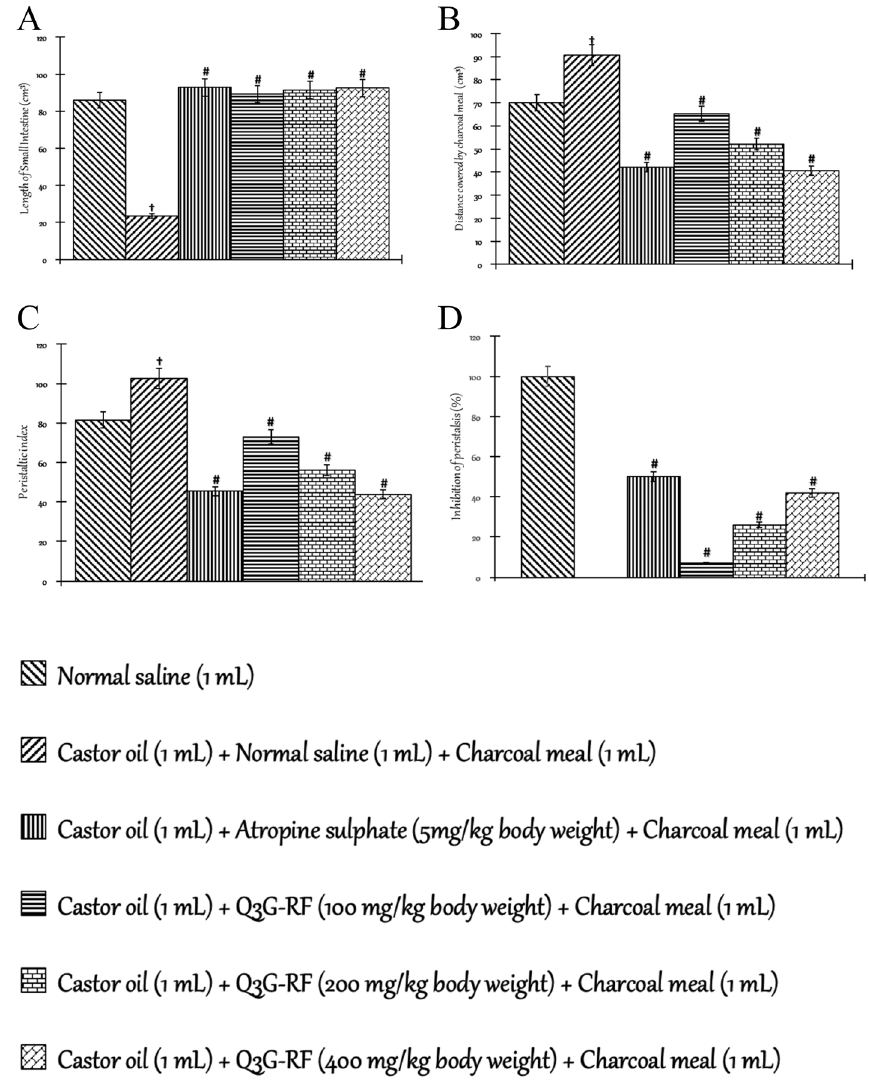
Fig. 8 Effect of Q3G-RF from S. mombin leaves on gastrointestinal motility using charcoal. Length of small intestine ( A ), distance covered by charcoal meal ( B ), peristaltic index ( C ), and inhibition of peristalsis ( D ) of male Wistar rats treated with normal saline, castor oil (1 mL) normal + saline (1 mL) charcoal meal (1 mL), castor oil (1 mL) atropine sulphate (5 mg/kg body weight) charcoal meal (1 mL), castor oil (1 mL) + + + + Q3G-RF (100 mg/kg body weight) charcoal meal (1 mL), castor oil (1 mL) Q3G-RF (200 mg/kg body weight) charcoal meal (1 mL), and castor + + + oil (1 mL) Q3G-RF (400 mg/kg body weight) charcoal meal (1 mL). Values are expressed as mean standard error of mean ( n 6). Significant + + ± = differences from the sham control group are indicated by † and from negative control by #, p <